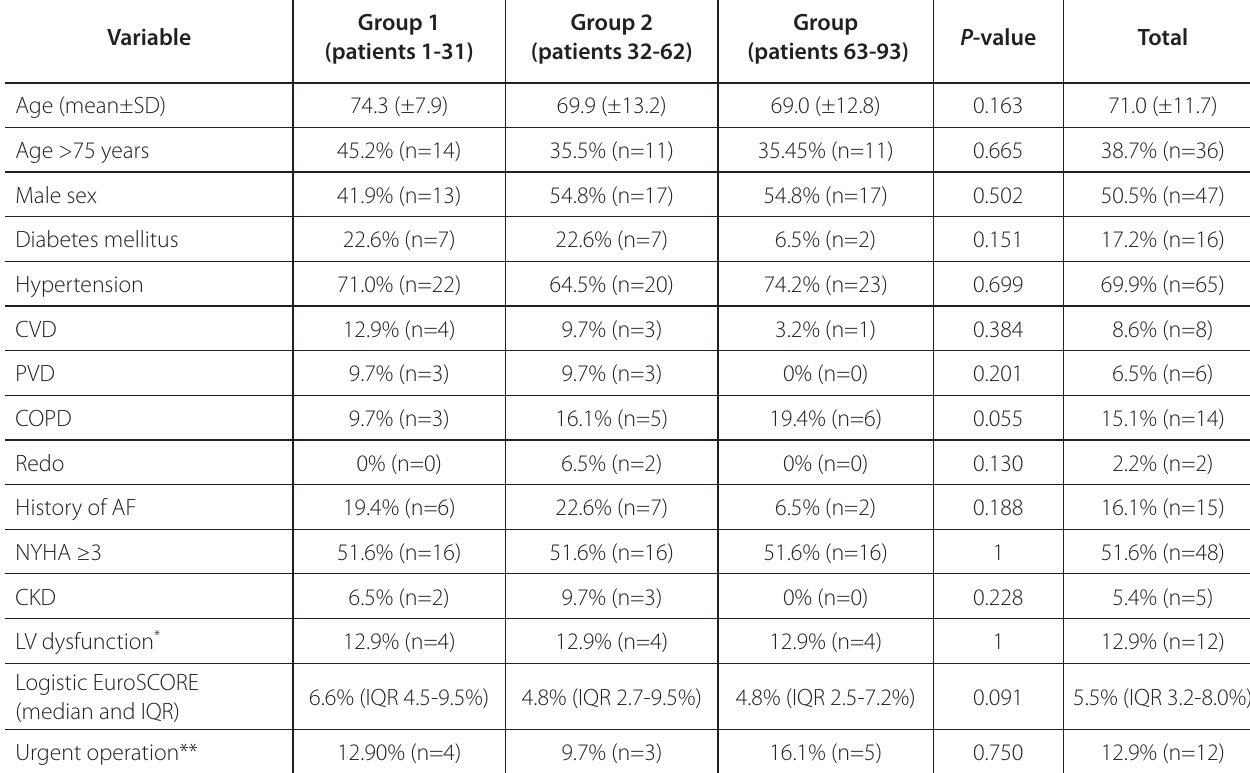
Table 1 . Patient